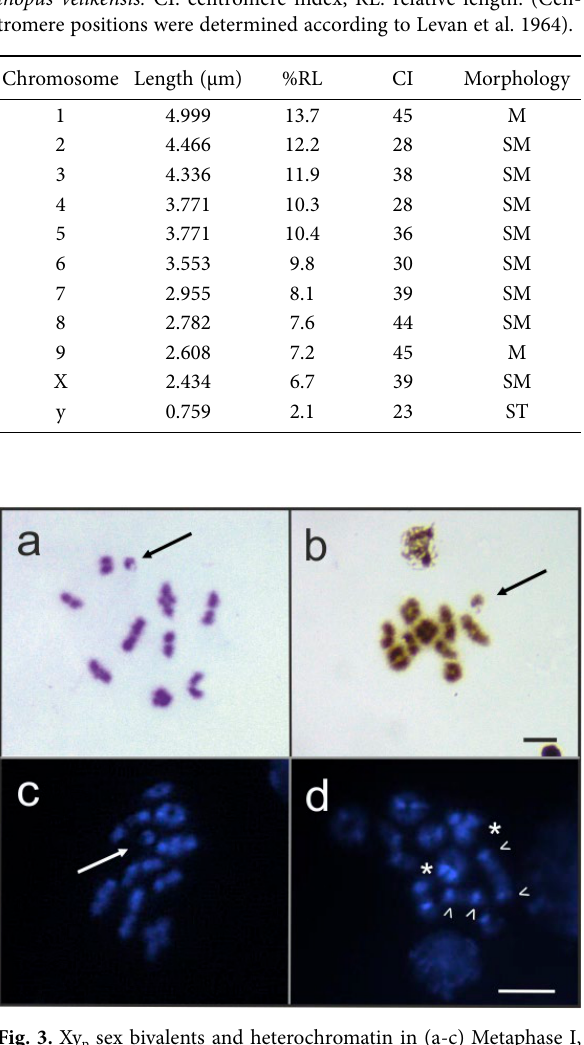
Fig. 3. Xy p sex bivalents and heterochromatin in (a-c) Metaphase I, (a) Giemsa (b) Silver nitrate ( c) DAPI staining (d) Diplotene-diaki- nesis (DAPI staining) Arrows show Xy p sex bivalents, asterisk show heterochromatin. Arrowheads indicate telomeric signals on some of the rod shaped bivalents Bars =